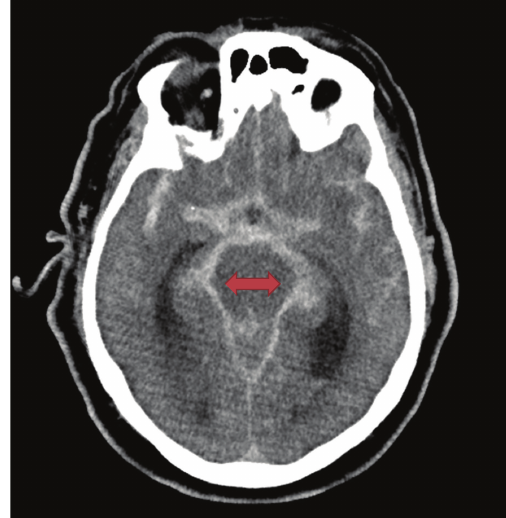
Figure 5: Hospital day 3 CT head without contrast: Di ff use sub- arachnoid blood products. There are also blood products layering within the occipital horns of the bilateral lateral ventricles. There are also subarachnoid blood products extending inferiorly surrounding the cervical cord. This is consistent with rupture of the patient’s known basilar artery aneurysm. The ventricles are further enlarged with findings of transependymal CSF migration. There is no